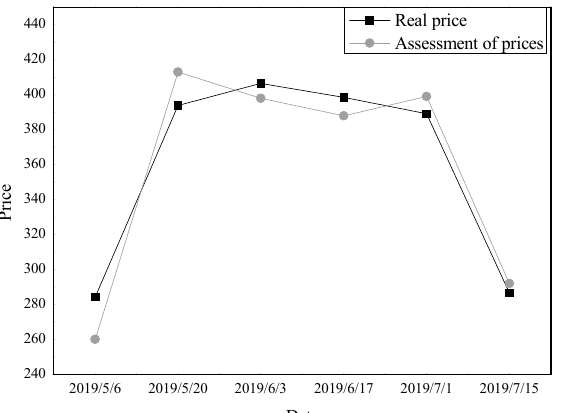
Figure 8. Bitcoin trend analysis based on SVM and Semantic Orientation Pointwise Mutual Information (SO-PMI) algorithms.